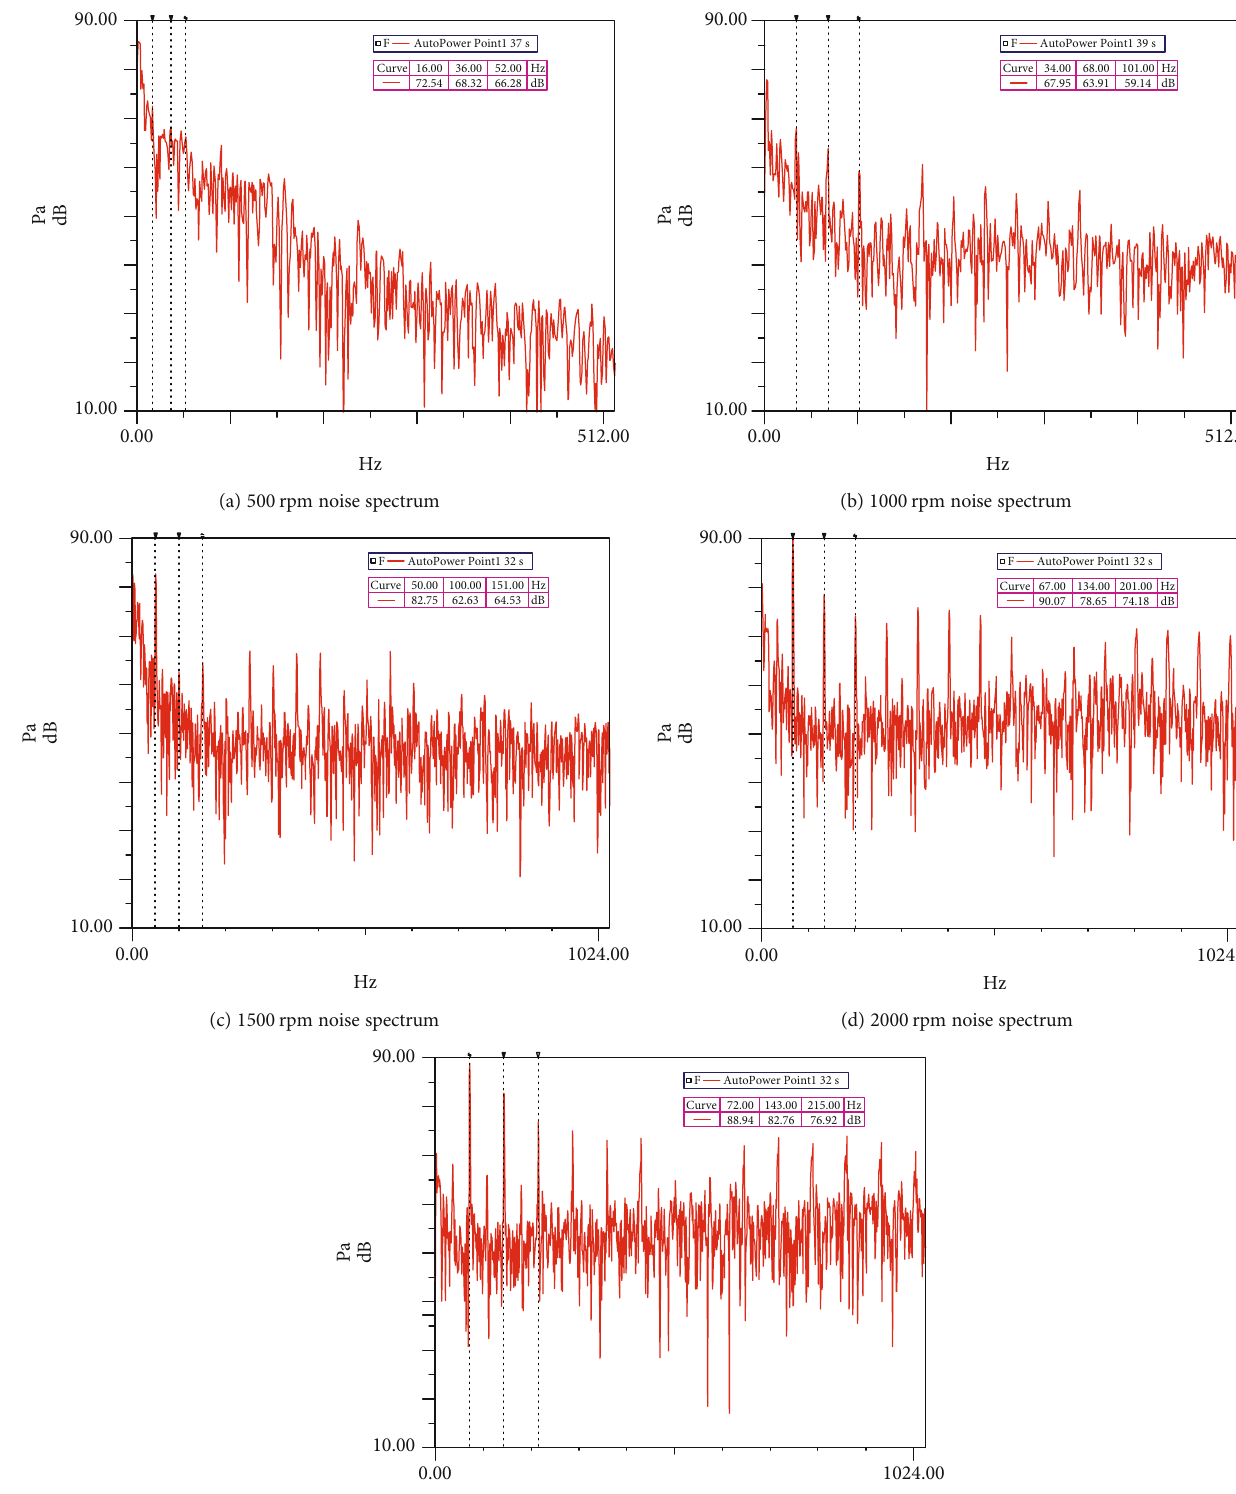
Figure 9: Noise spectrum in di ff erent